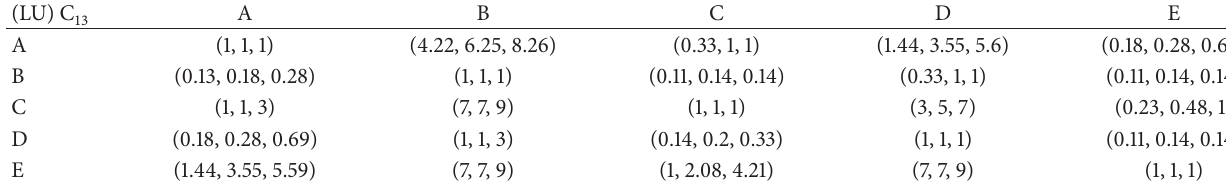
Table 6: Options concerning LU subcriteria.